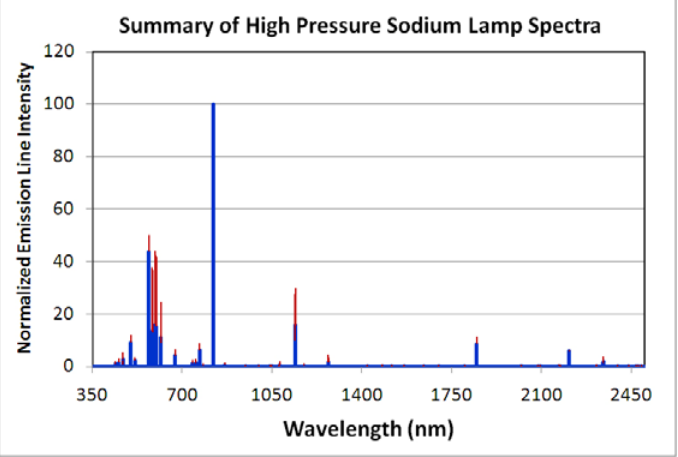
Figure 15. Spectral variability of metal halide lamps. Each of the three spectra were normalized to 1.0 and then an average (blue) and standard deviation (red) were